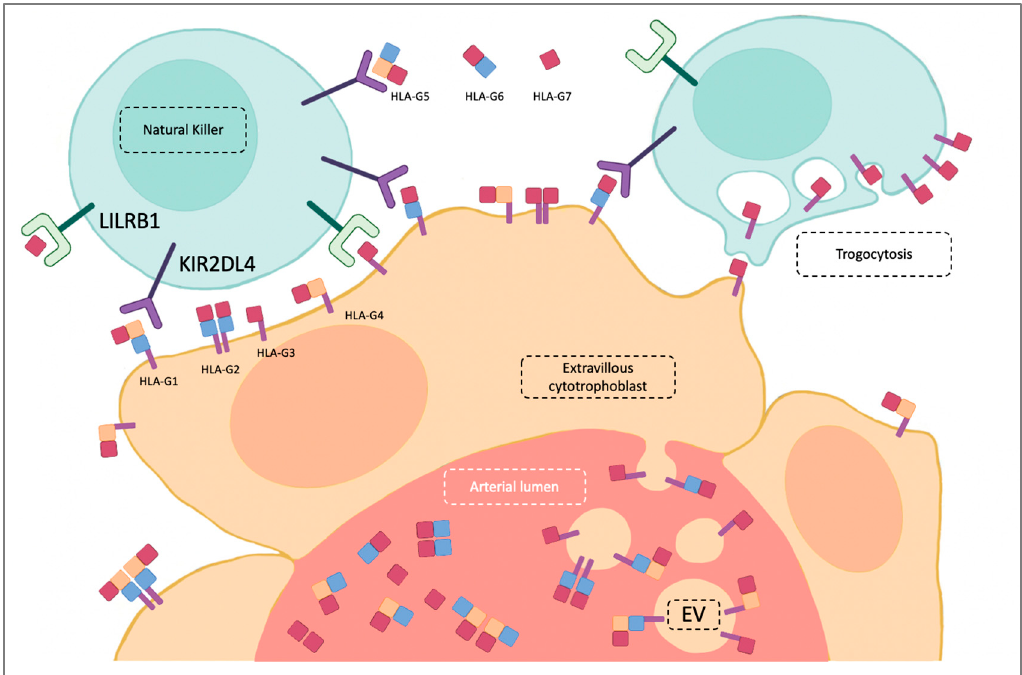
Figure 3. Extravillous cytotrophoblast cells (EVT) and natural killer (NK) interactions. HLA-G isoforms expressed on extravillous cytotrophoblast interact with LILRB1 and KIR2DL4 on NK surface. In addition, by trogocytosis, placental NKs (pNKs) can acquire HLA-G membrane-binding isoforms on their surface. Soluble HLA-G isoforms can be spread in circulation and in the extracellular matrix. In addition, membrane-binding HLA-G isoforms can be spread when carried on extracellular vesicles (EV).